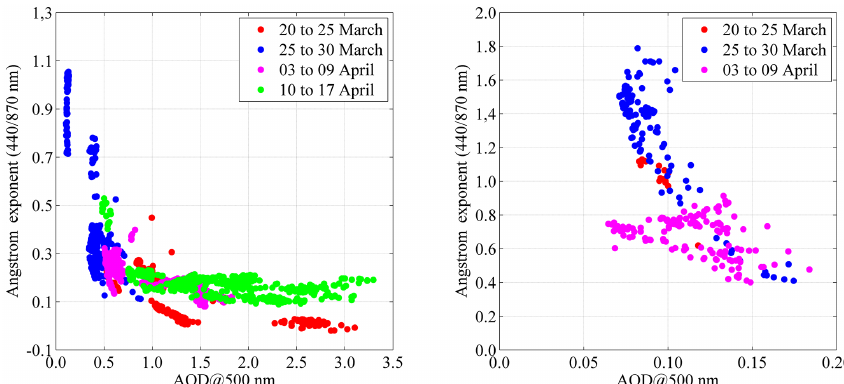
Figure 3. Ångström exponent (AE) calculated using aerosol optical depth (AOD) from 440 and 870nm as a function of AOD at 500nm (AOD at 500nm) using data from AERONET sun photometers installed in Ilorin (08 ◦ 19 (cid:48) 12 (cid:48)(cid:48) N, 04 ◦ 20 (cid:48) 24 (cid:48)(cid:48) E – left plot) and upwind of Manaus in central Amazonia (02 ◦ 53 (cid:48) 12 (cid:48)(cid:48) S, 59 ◦ 58 (cid:48) 12 (cid:48)(cid:48) W – right plot) during distinct phases of the sampling period (20 March to 17 April).